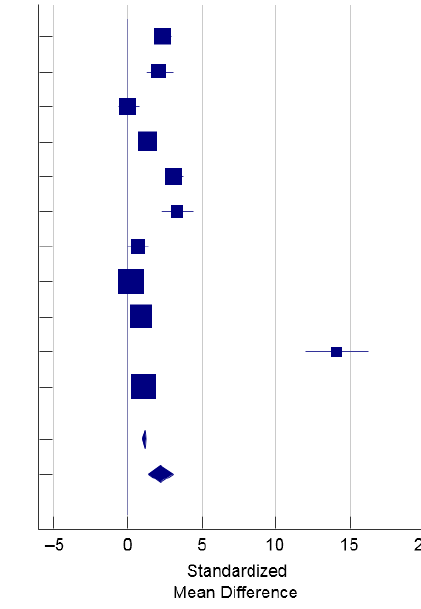
Figure 5. Funnel Plot examining trials of 25OHD responses with vitamin D supplementation.